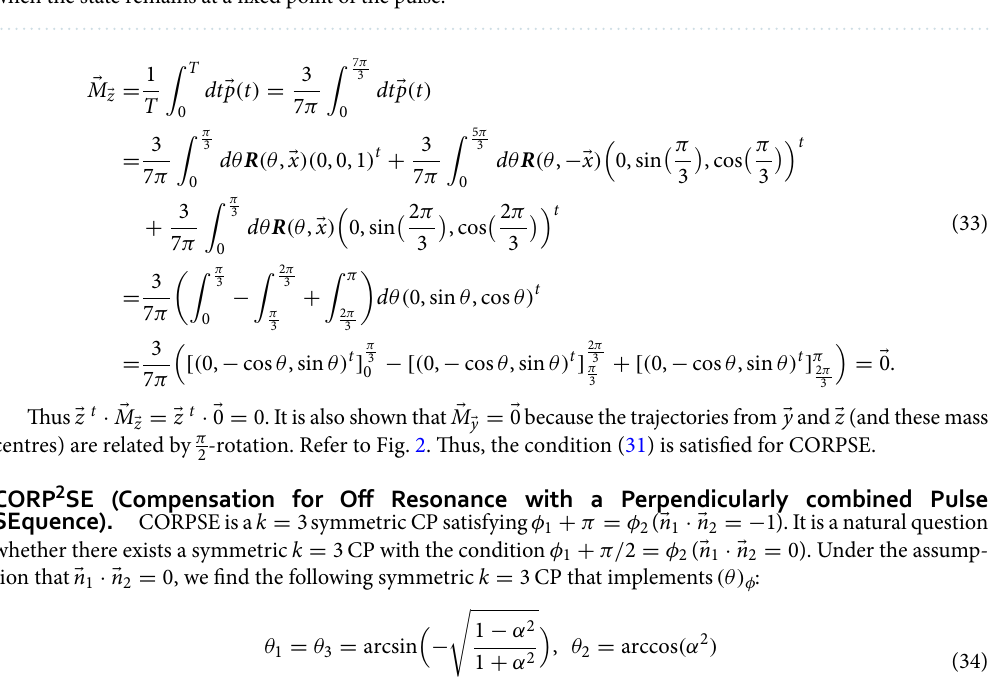
Figure 3. Errorless trajectories by CORP 2 SE. The left, middle, and right panels show the initial state. The initial (final) states are represented by the blue (red) points. The blue, green, and red lines represent the first, second, and third pulse trajectories, respectively. The black arrows show the action of pulses when the state remains at a fixed point of the